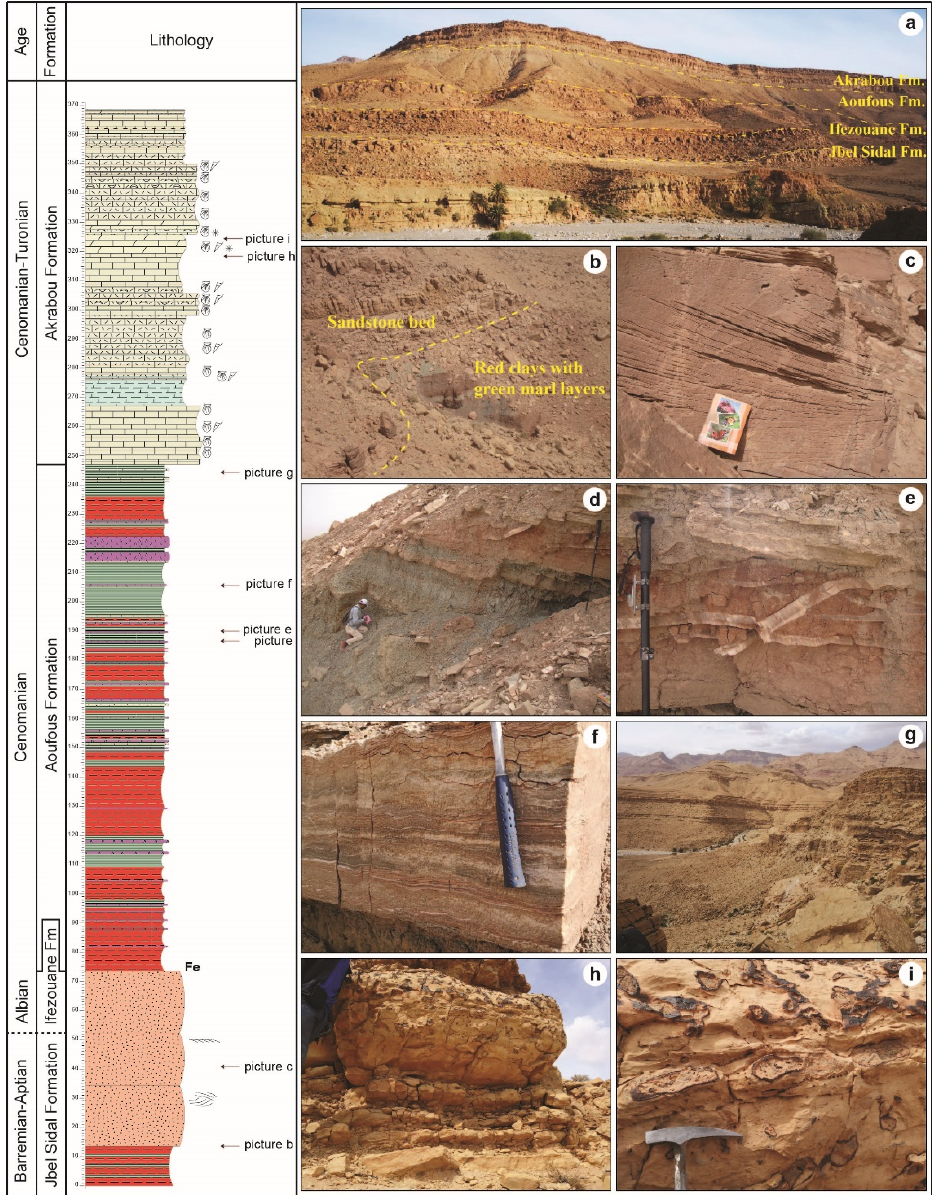
Figure 5. Errachidia section. ( a ) east–west landscape showing the Cretaceous series of Errachidia; ( b ) view of the thick reddish sandstone bed resting on variegated facies; ( c ) cross-sectional view of an oblique stratification in a reddish sandstone bed; ( d ) greenish marly facies; ( e ) cross-section of a clayey facies intersected by secondary gypsum slits (Neptunian dykes); ( f ) close-up view of a primary gypsum bed; ( g ) general view showing a succession of limestone resistant units separated by intervals of terrigenous sediments; ( h ) dolomitic limestone presenting small geodes with a blackish ferruginous crust; ( i ) small geodes which show a calcareous filling with bivalve shells.